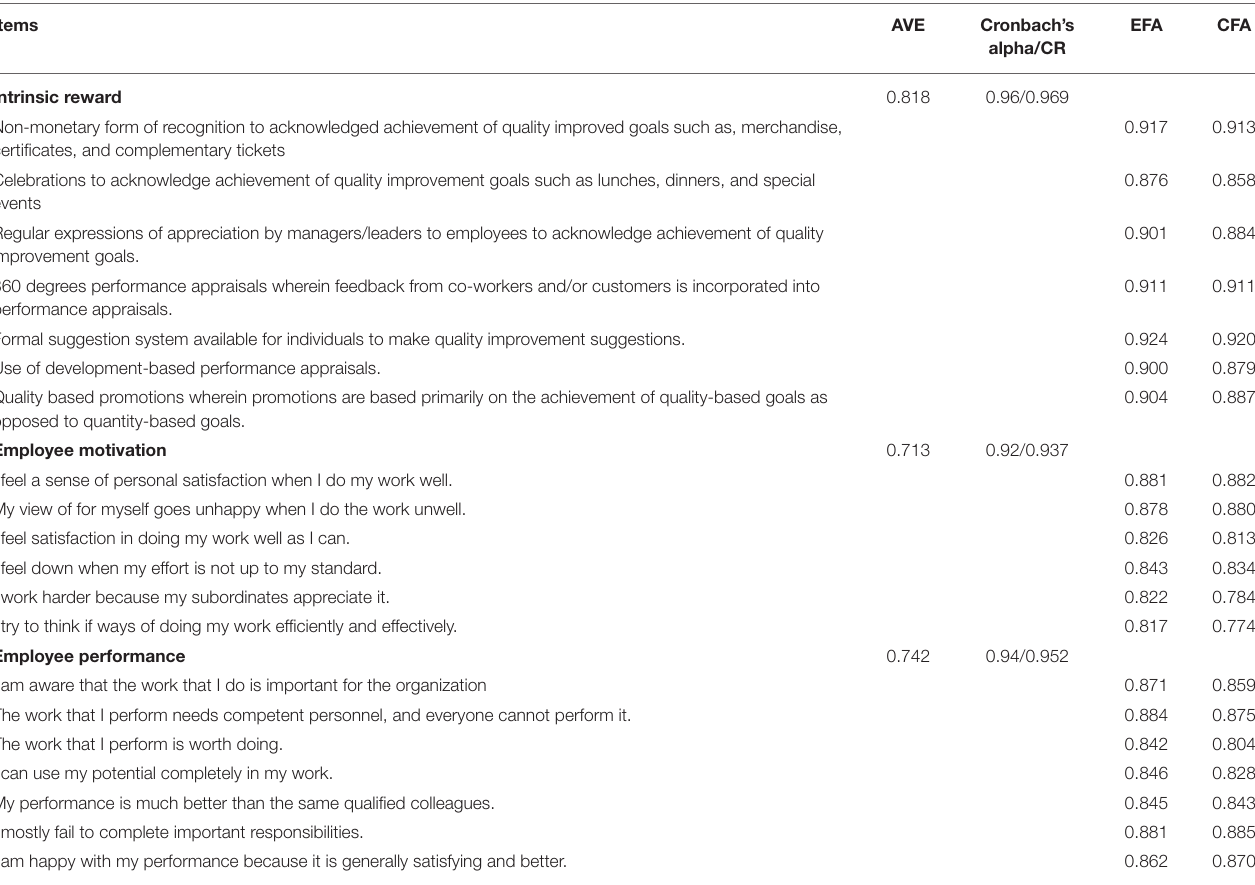
TABLE 3 | Factor loading of indicators and overall reliability of the constructs.